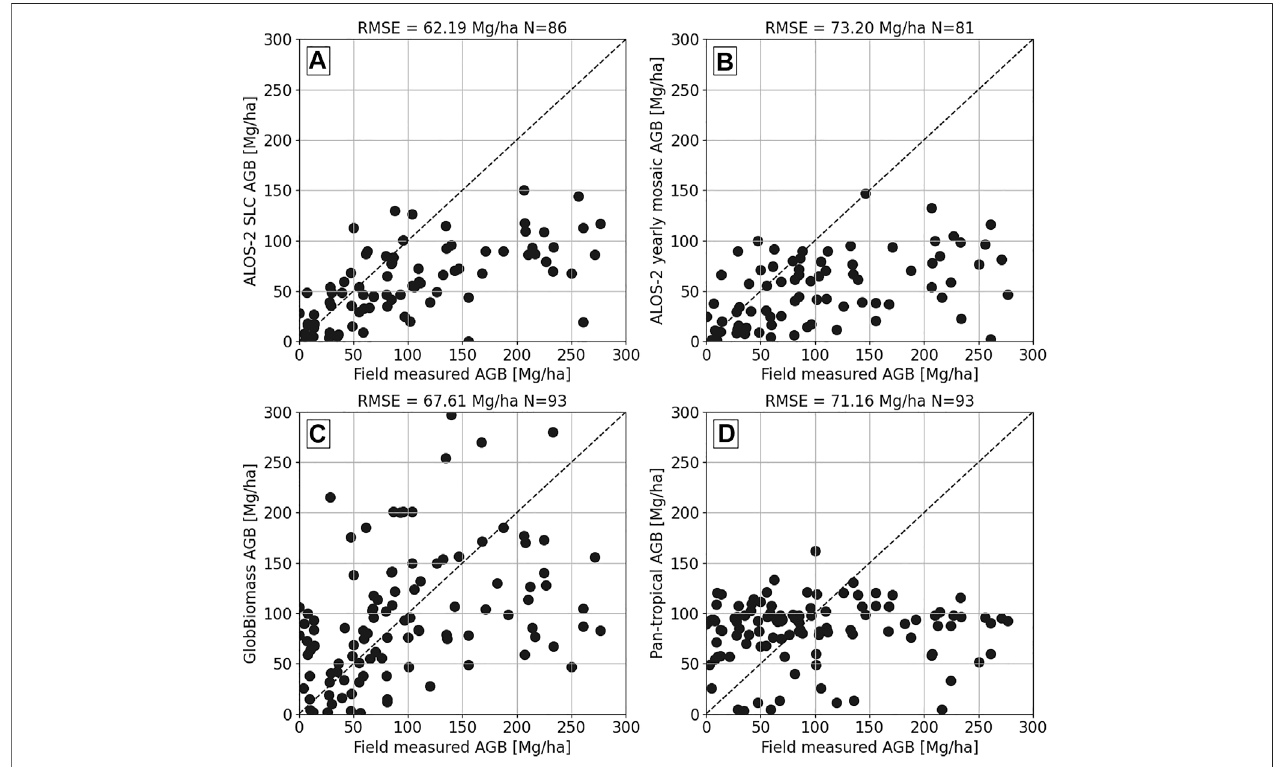
FIGURE 13 | The validation scatter plots compare the fi eld measured AGB with the multitemporal mean AGB of (A) 23 ALOS-2/PALSAR-2 SLC acquisitions, (B) yearly ALOS-2/PALSAR-2 global mosaics, (C) GlobBiomass (Santoro, 2018), and (D) pan-tropical AGB (Avitabile et al., 2016).